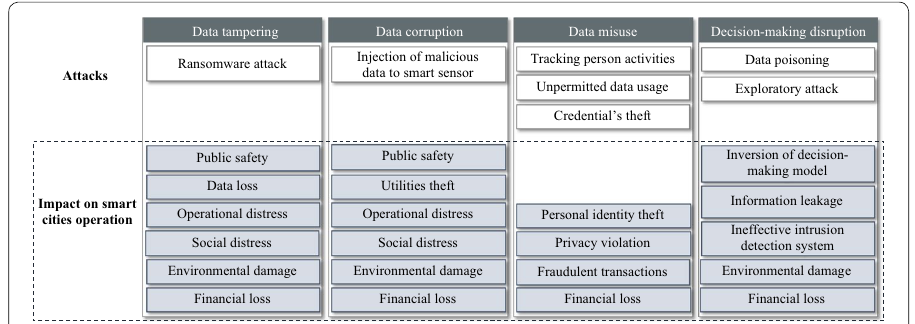
Fig. 6 Data manipulation threats in smart cities’ settings: attacks and